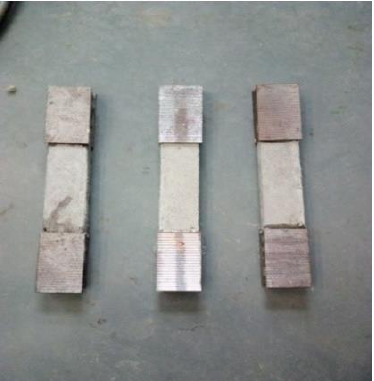
Figure 4: Experimental set-up for niaxial tensile